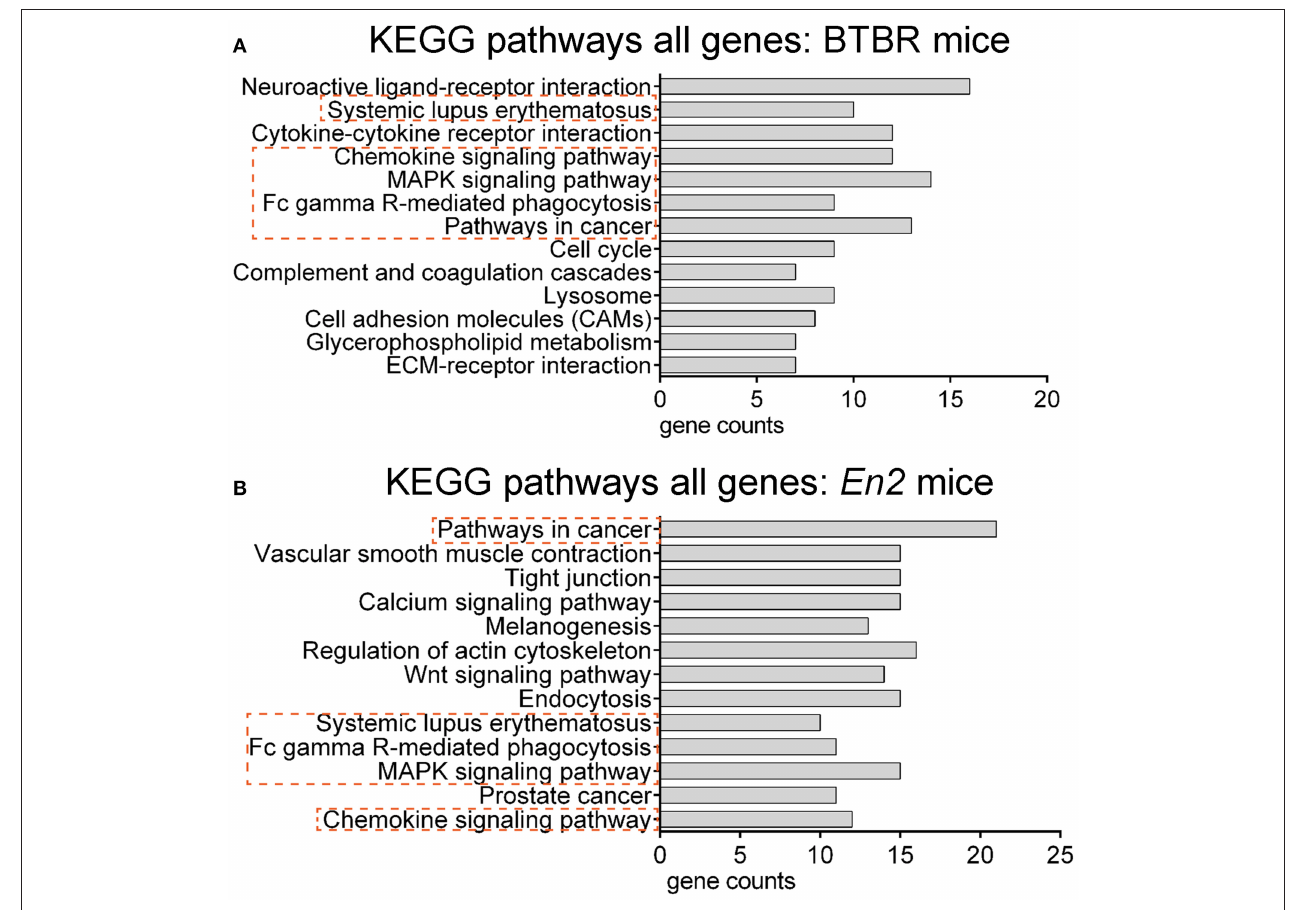
FIGURE 4 | Overrepresented pathways categories for differentially expressed genes in BTBR and En2 − / − hippocampi. BTBR and En2 − / − hippocampal DEGs were analyzed for enrichment in KEGG pathways categories using DAVID, with an adjusted p < 0.05. For each category, the number of genes is indicated by the length of horizontal bars (gene counts). Dashed red lines highlight pathways common to BTBR (A) and En2 − / − (B) DEGs.